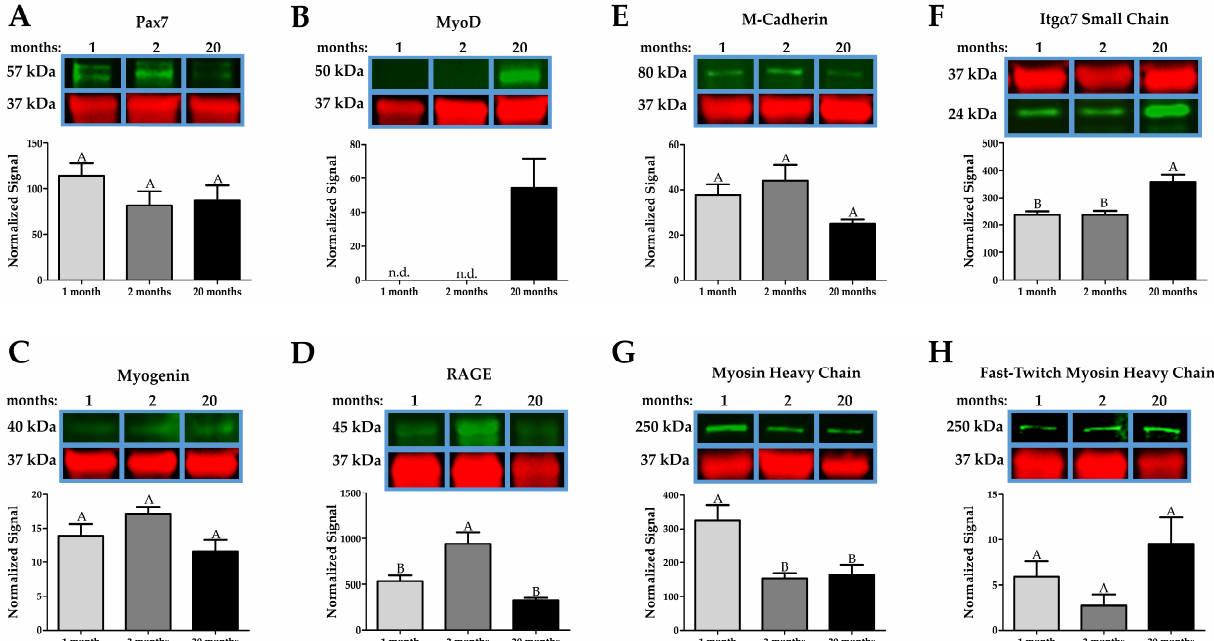
Figure 2. Western blotting differences in muscle-specific factors with age. ( A , B ) Pax7 does not change with age, suggesting that the satellite pool is unchanged at 20 months, while MyoD remains undetected (n.d. indicates not detected) until 20 months, indicating homeostatic compensation of the muscle. ( C ) Myogenin is marginally reduced at 20 months. ( D ) Curiously, RAGE (receptor for advanced glycation end products) decreased from 2 to 20 months. ( E ) M-cadherin is decreased in old age. ( F ) Integrin α 7 is increased at 20 months, which might be a compensatory response by the muscle. ( G ) Myosin Heavy Chain is unchanged in old age compared to 2 months, indicating that muscle aging does not affect contractile units at 20 months. ( H ) There is no difference in the Fast-Twitch Myosin Heavy Chain, further indicating that 20 months is not old enough to see sarcopenic effects. The red bands are GAPDH. Groups that do not share a letter (e.g. A or B) are statis ‐ tically different according to a one ‐ way ANOVA followed by a two ‐ tailed Tukey’s correction ( p < 0.05, n = 6).